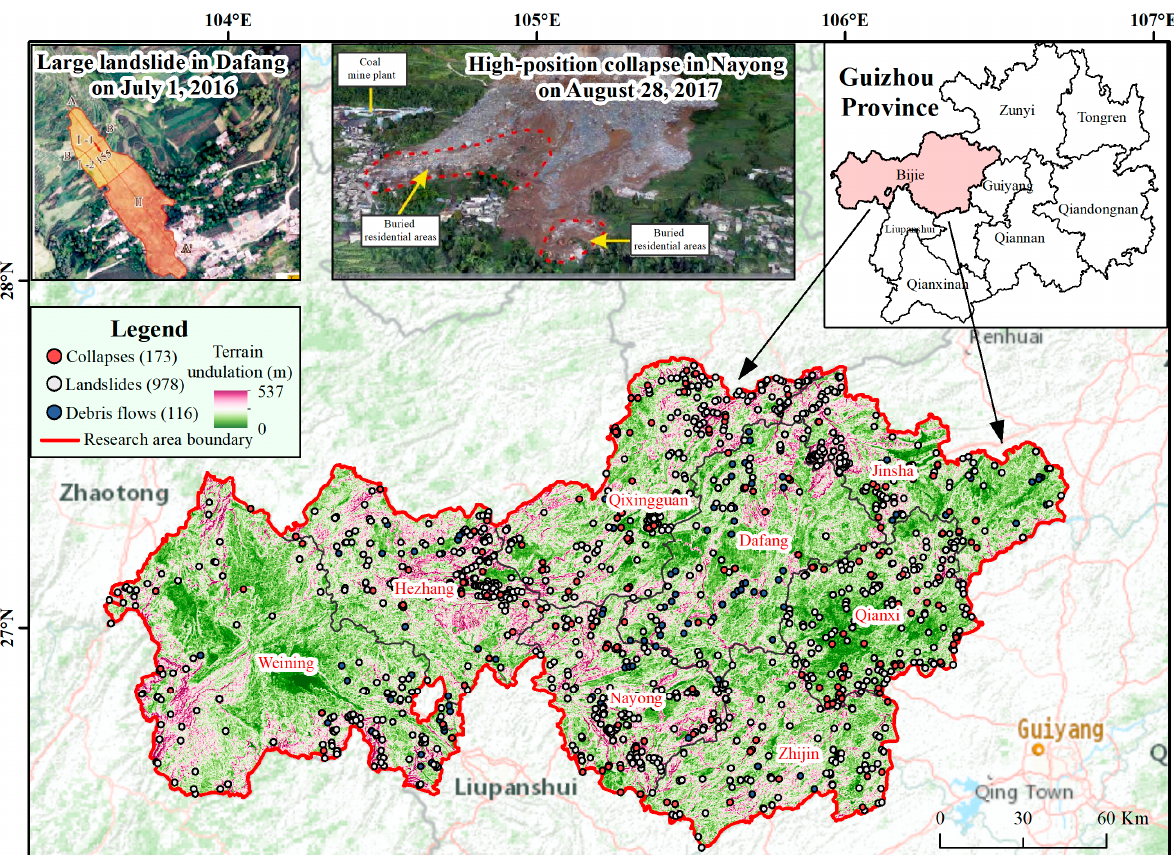
Figure 1. Overview of the study area. The landslide events in this data set are divided into 3 categories: collapse, landslide, and debris flow. (Illustrations of the landslide in Dafang and the collapse in Nayong are cited by Zhang et al. [39] and Zheng et al. [40], respectively.)